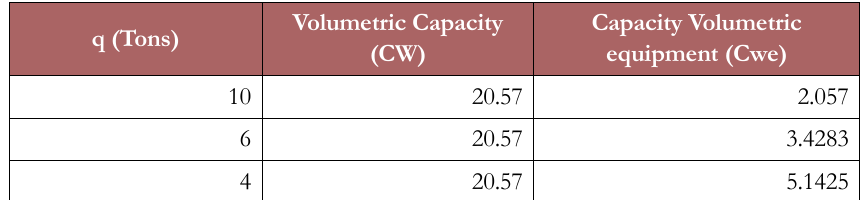
Table 9. Volumetric capacity of the